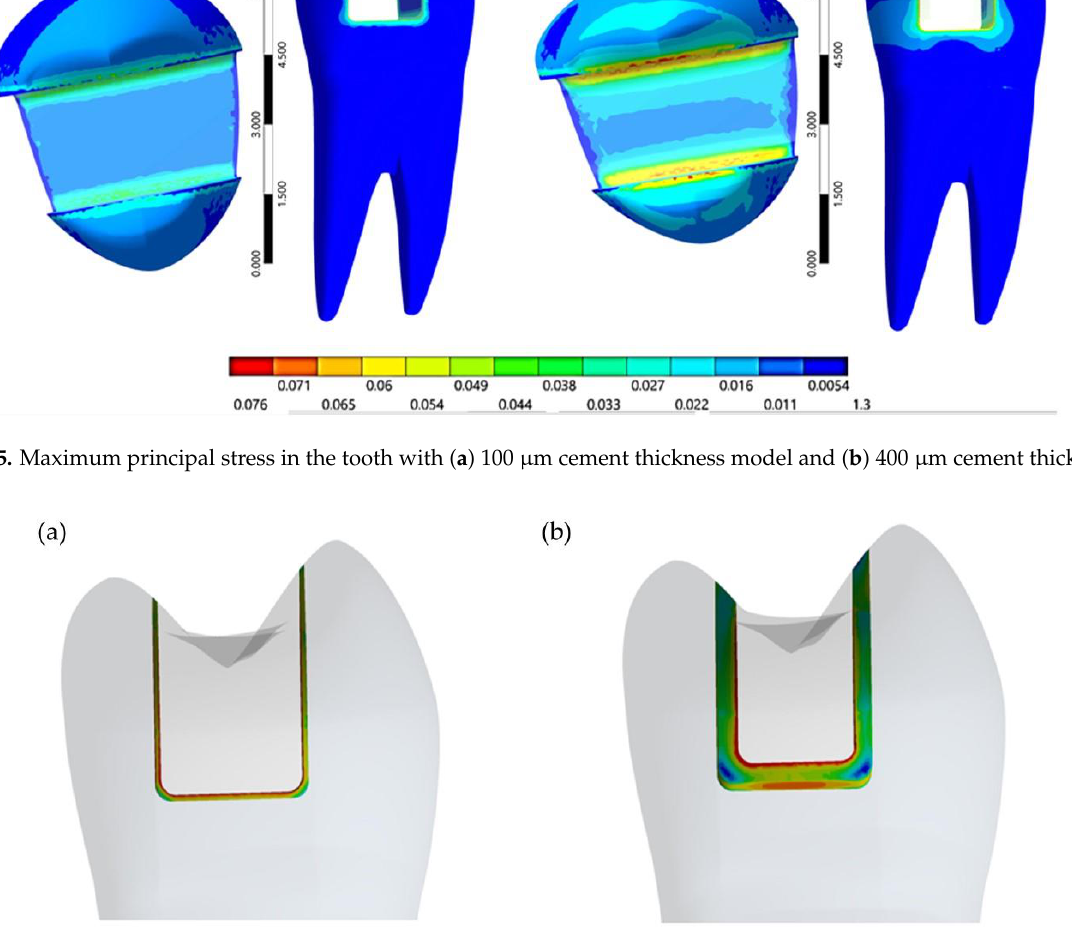
Figure 6. Maximum principal stress in the cement layer with ( a ) 100 μm cement thickness model and ( b ) 400 μm cement thickness.